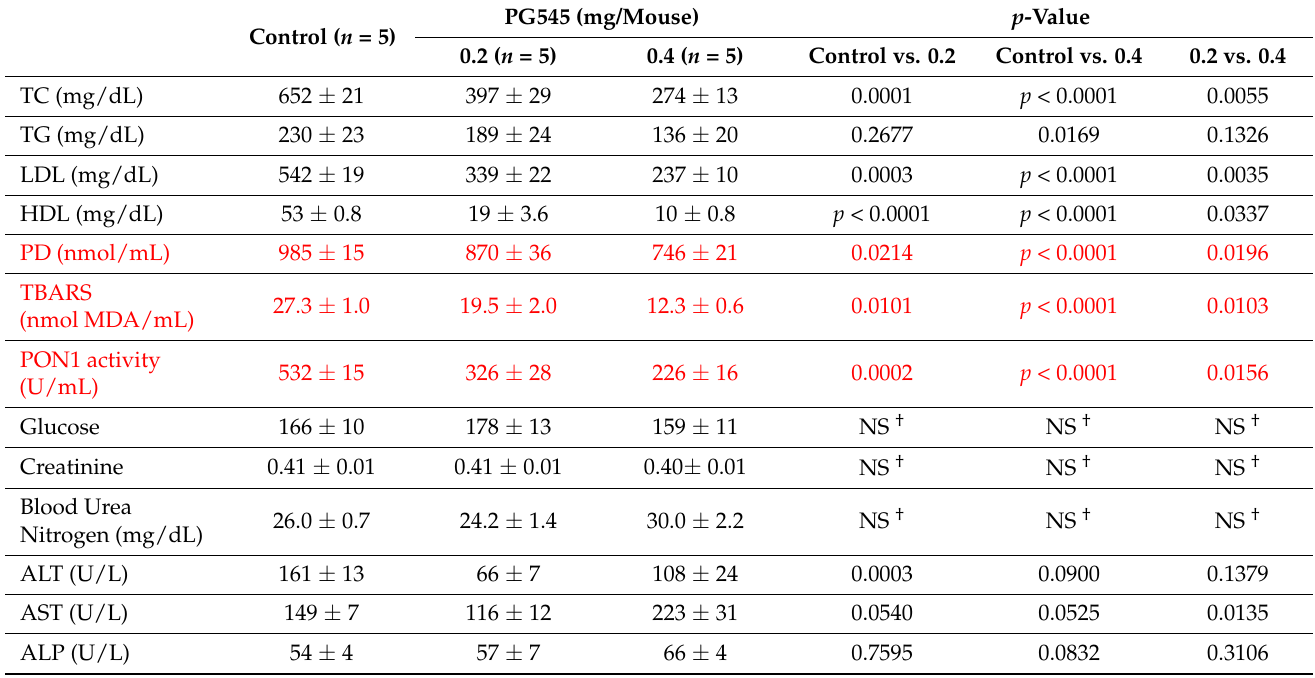
Table 2. Biochemical parameters in sera of mice groups. PG545 caused dose-dependent decrease in levels of TC, TG, LDL, HDL, and oxidative stress parameters (marked in red). Levels of glucose, creatinine, and liver enzymes were not significantly affected by the inhibitor. Results are expressed as mean ± SEM.